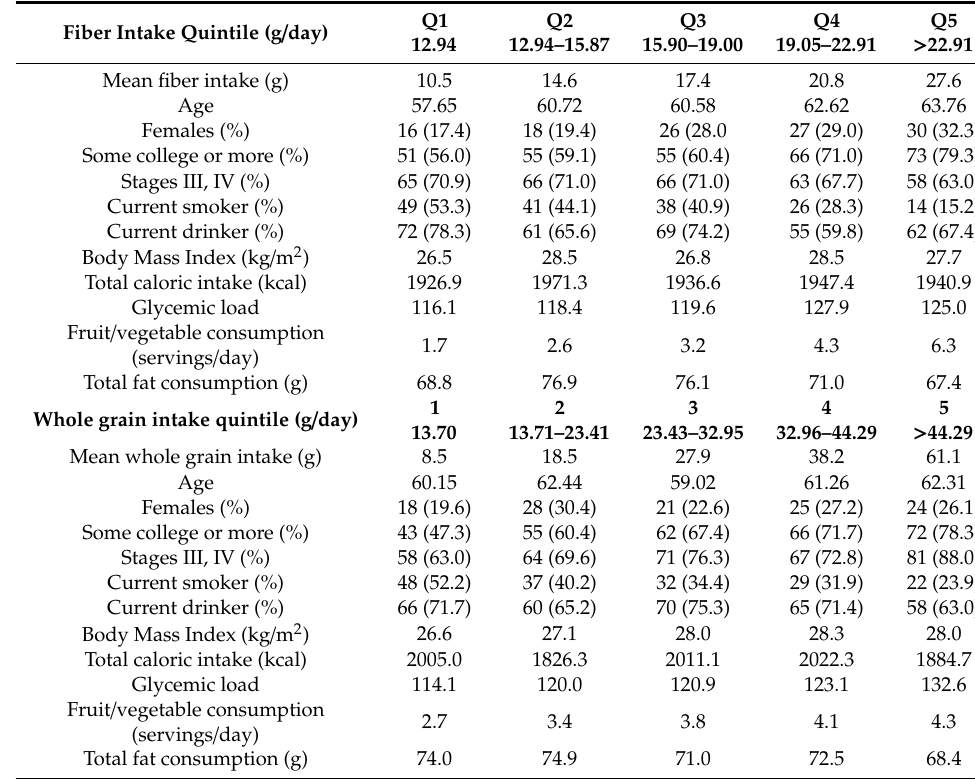
Table 2. Select epidemiological characteristics according to quintile (Q) of dietary fiber or whole grain